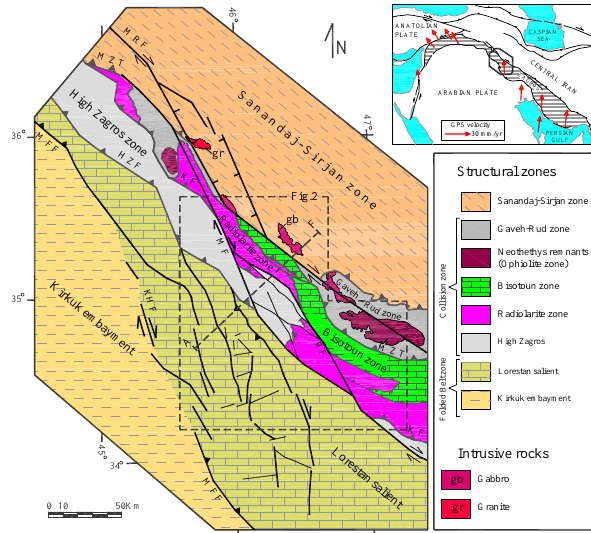
Figure 1. Zagros orogen in NW Iran and NE Iraq (Kurdistan area). Abbreviations: HZF – High Zagros Fault; KF – Kermanshah Fault; KHF – Khaneqin Fault; MF – Marekhil Fault; MFF – Mountain Front Fault; MZT – Main Zagros Thrust. Line A–F is the location of the regional cross section presented in Fig. 6. The inset shows location of the studied area on the geodynamic map of the Zagros. Arrows indicate GPS velocities from McClusky et al. (2000) and Vernant et al.